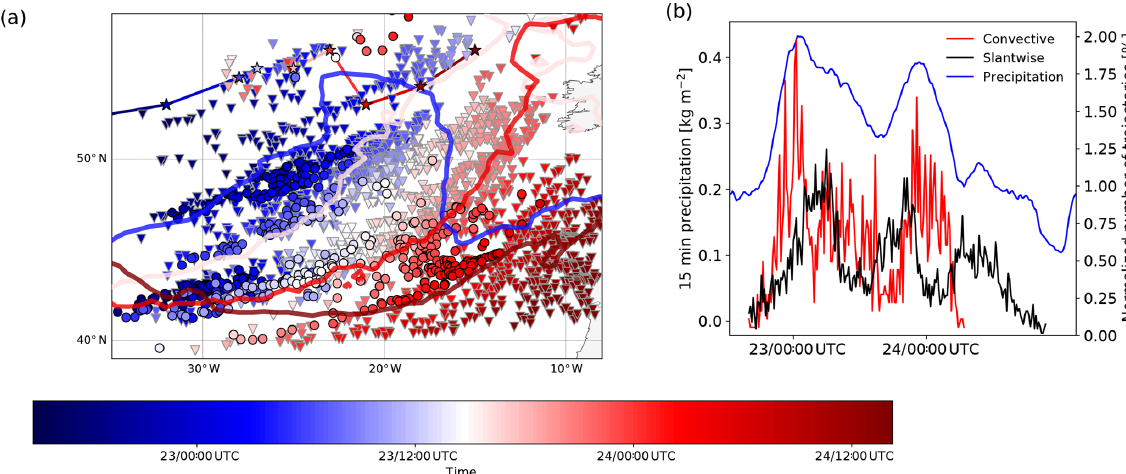
Figure 3. (a) Location of convective (black-outlined circles) and slantwise (grey-outlined triangles) WCB trajectories at the start of the fastest 400hPa ascent phase. Colors indicate the according time of the WCB air parcel position (blue 23 September, red 24 September). Only every fourth trajectory is shown. The evolution of the frontal structures is indicated by θ = 293K at 850hPa (lines are colored according to the selected times at 04:00UTC, 23 September; 16:00UTC, 23 September; 04:00UTC, 24 September; and 16:00UTC, 24 September). The asterisks indicate the location of the surface cyclone every 6h (colored according to time). (b) Temporal evolution of the number of selected convective (red) and slantwise (black) WCB trajectories at the start of the fastest 400hPa ascent phase normalized by the absolute number of selected trajectories in each category and evolution of 15min accumulated precipitation averaged over the WCB domain shown in (a) . Note that for the domain-averaged precipitation only grid points with nonzero precipitation were